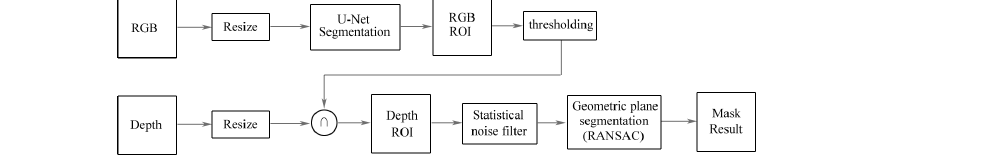
FIGURE 10 Architecture based on U-Net for the automatic segmentation of DFUs (52). Images with RGB information are inputted into the U-Net model to obtain the ROI. Then, the ROI is set on the depth image. After a second segmentation is applied to extract geometric models, the results of semantic segmentation are obtained from the